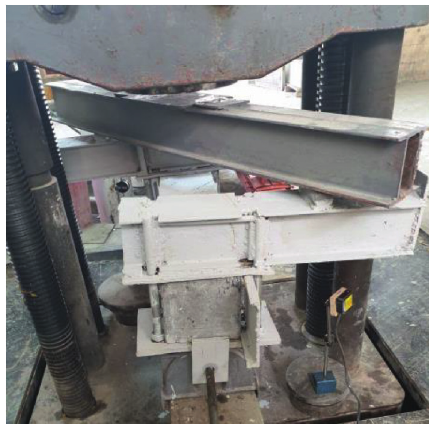
Figure 6: Test Table 3: Summary of test results.